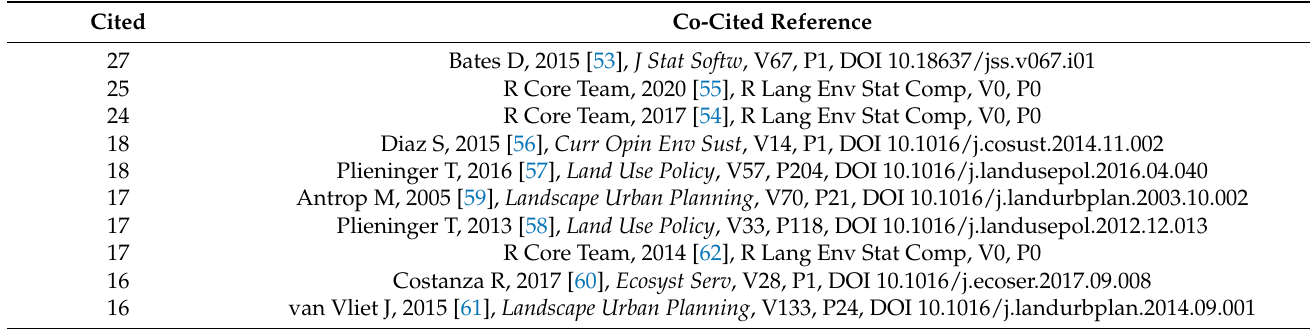
Table 2. The top 10 co-cited references from 1990 to